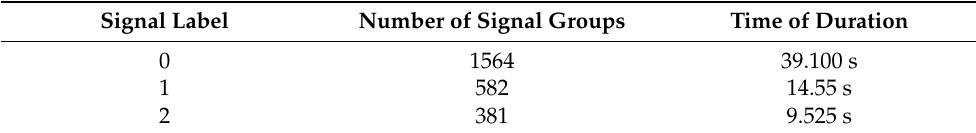
Table 4. Statistical table of classi fi cation results. Signal Label